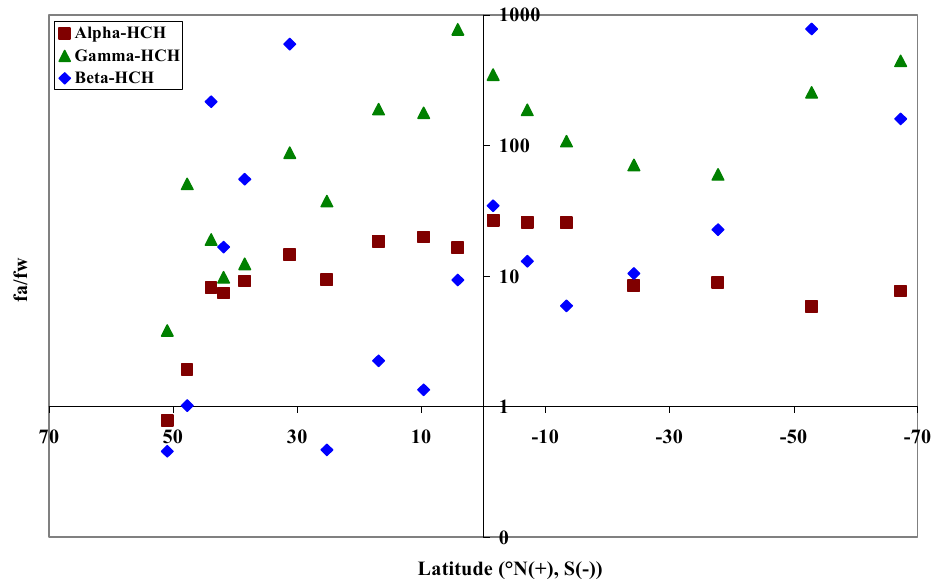
Fig. 5. Air-water fugacity ratio ( f A / f W ) of α -, γ - and β -HCH in the Atlantic and Southern Ocean, a f A / f W within the range 0.3–3 means a Figure 5. system at equilibrium.